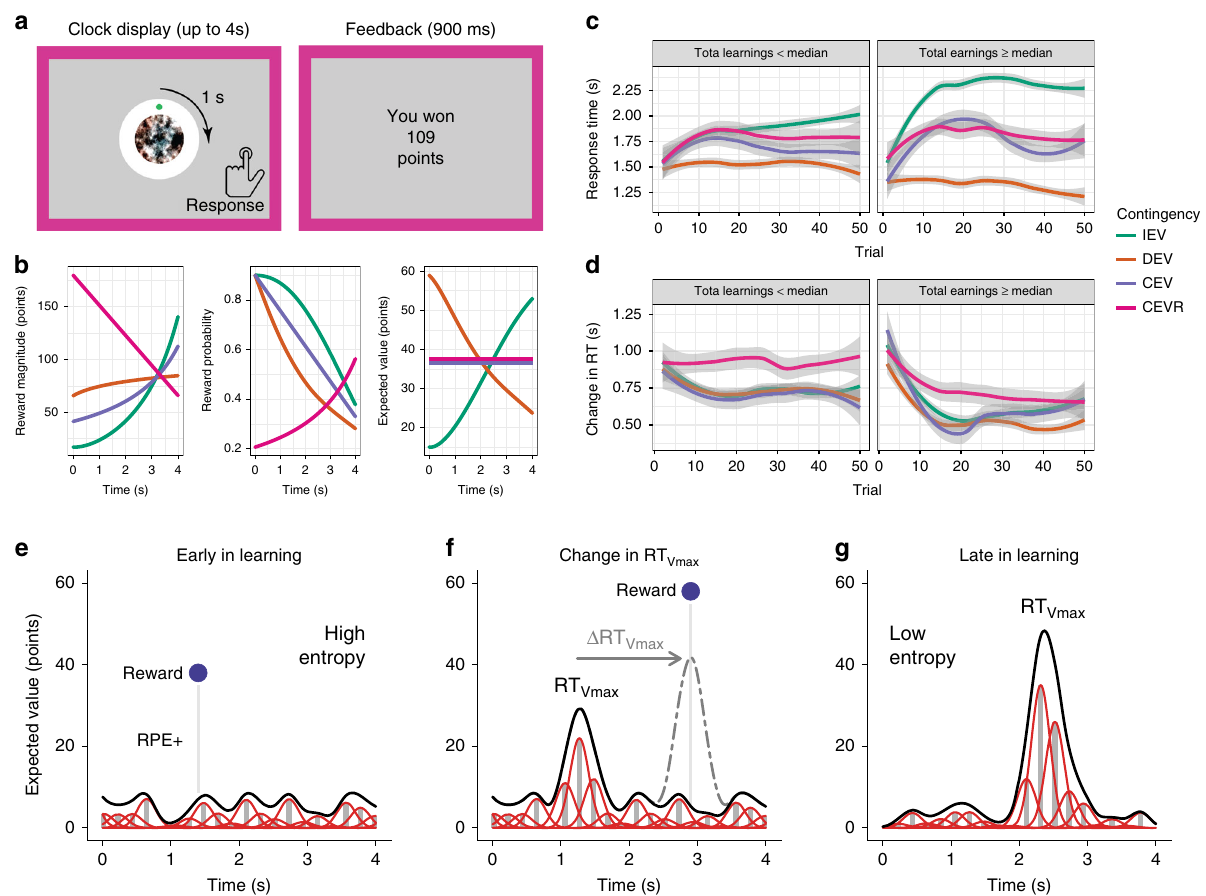
Fig. 1 The clock paradigm, typical human behavior, and the SCEPTIC model. a The clock paradigm consists of decision and feedback phases. During the decision phase, a dot revolves 360° around a central stimulus over the course of 4 s. Participants press a button to stop the revolution and receive a probabilistic outcome. b Rewards are drawn from one of four monotonically time-varying contingencies: increasing expected value (IEV), decreasing expected value (DEV), constant expected value (CEV), or constant expected value-reversed (CEVR). CEV and CEVR thus represent unlearnable contingencies with no true value maximum. Reward probabilities and magnitudes vary independently. c Evolution of subjects ’ response times (RT) by contingency and performance. Panels represent participants whose total earnings were above or below the sample median. Shaded error bands depict the standard error. n = 70 participants. d Evolution of subjects ’ response time swings (RT swings) by contingency and performance. n = 70 participants. e When all response times have similar expected values, the entropy of the value distribution is high, promoting entropy-guided exploration in the SCEPTIC model. A better-than-expected reward generates a positive reward prediction error (RPE + ), which updates the value distribution. f Participants